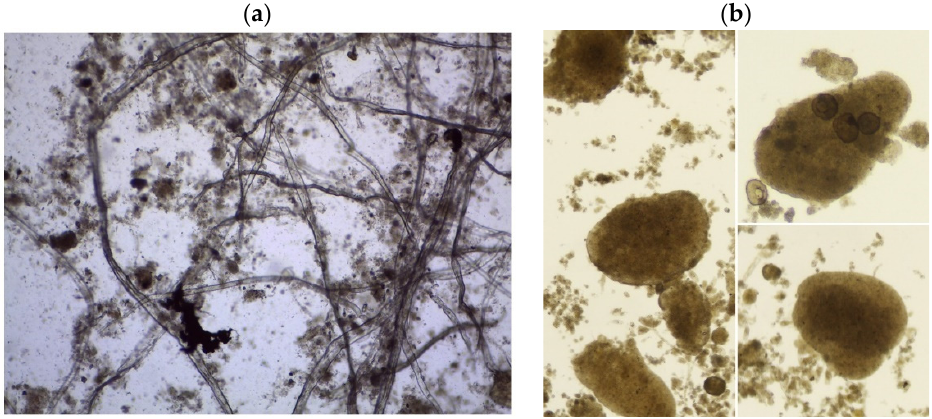
Figure 2. Microscopic image of ( a ) CAS (100× magnification) and ( b ) AGS used in the experiment (100× magnification).